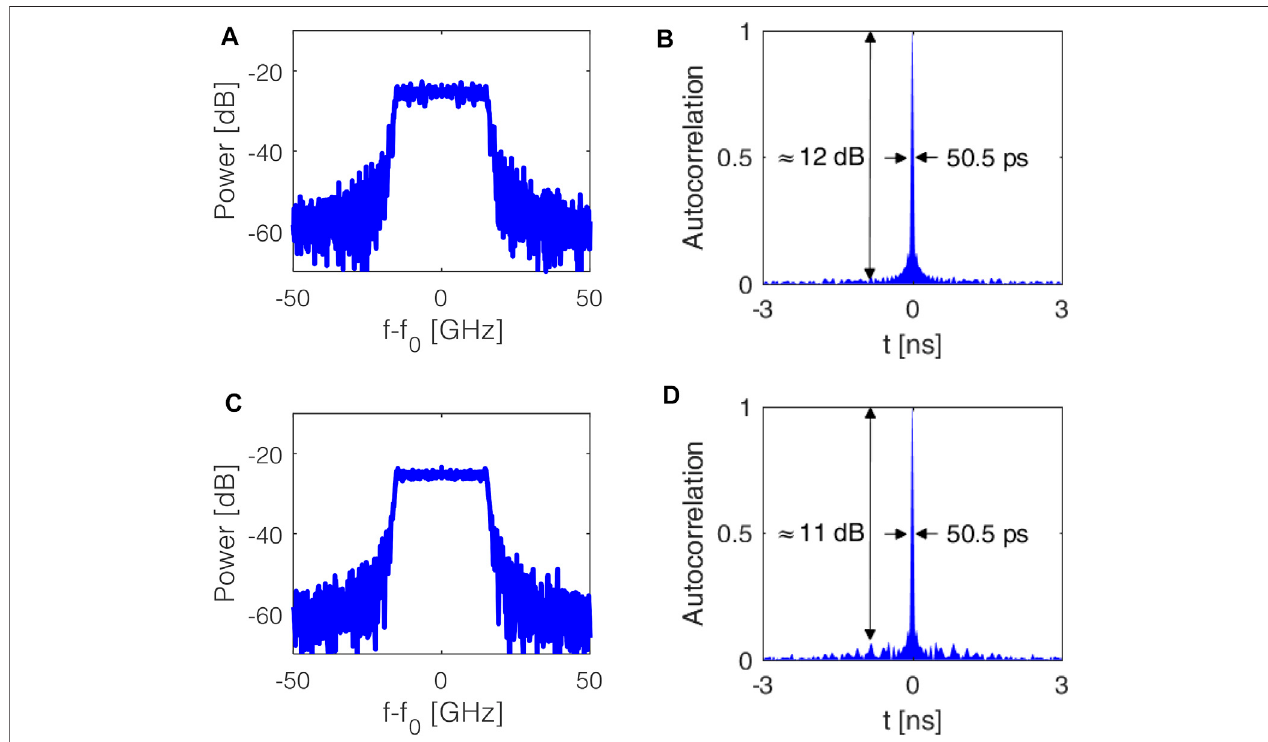
FIGURE 5 | (A) RF spectrum and (B) autocorrelation function of the RPML output with V pp = 0.8 V, N = 20, M = 20; (C) RF spectrum and (D) autocorrelation function of the RPML output with V pp = 0.8 V, N = 10, M =